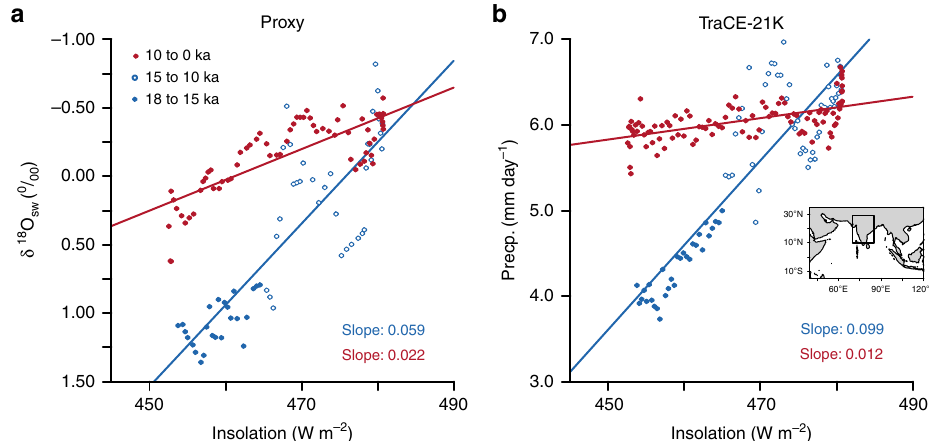
from the core KL-126 from the Bay of Bengal 38 and summer Fig. 1 The sensitivity of the Indian summer monsoon to insolation. a The scatter of δ 18 O sw insolation (Jun – Jul – Aug) over India (10 (cid:1) – 29 (cid:1) N and 70 (cid:1) – 85 (cid:1) E). The δ 18 O represents salinity in the northern Bay of Bengal (from where the sediment core sw is taken), and is in fl uenced by precipitation over the Indian subcontinent. Thus, δ 18 O is a proxy for the Indian summer monsoon. b The scatter of Indian sw summer monsoon rainfall (Jun – Jul – Aug) versus insolation over India from the TraCE-21k dataset. The blue and red fi lled circles denote the time periods (18 – 15 ka) and (10 – 0 ka), respectively. Open blue circles indicate the time period between (15 and 10 ka). This period experienced large centennial to millennial-scale excursions. Every circle represents an average over a century. The region chosen for this study is outlined with a black box within the inset (only land grids were considered). The blue and the red lines are the least-square fi t for the periods (18 – 10 ka) and (10 – 0 ka),